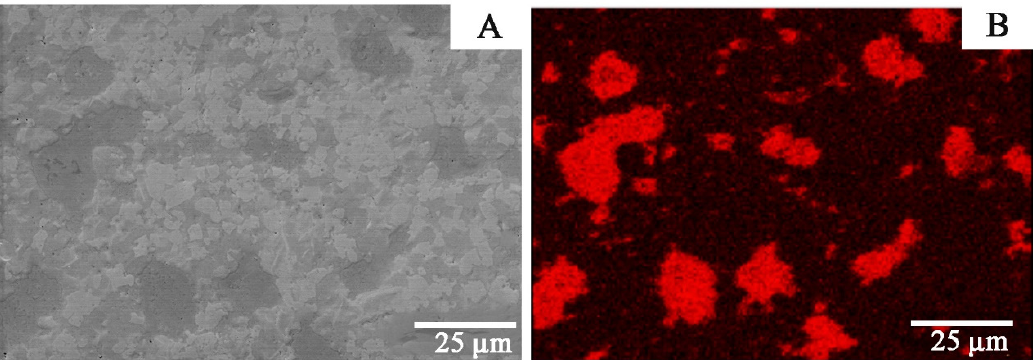
Figure 5. The Zr-2.5Cu microstructure obtained by the sintering (SPS) process is presented: ( A ) SEM microstructure; ( B ) Cu distribution for this microstructure.